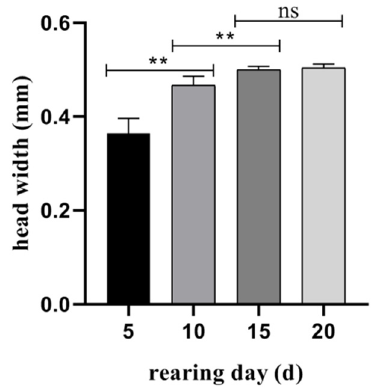
Figure 4. Differences in larval head width of Acanthotomicus suncei reared on the artificial diet. Mean ± SD, ** p < 0.01, ns = not significant.